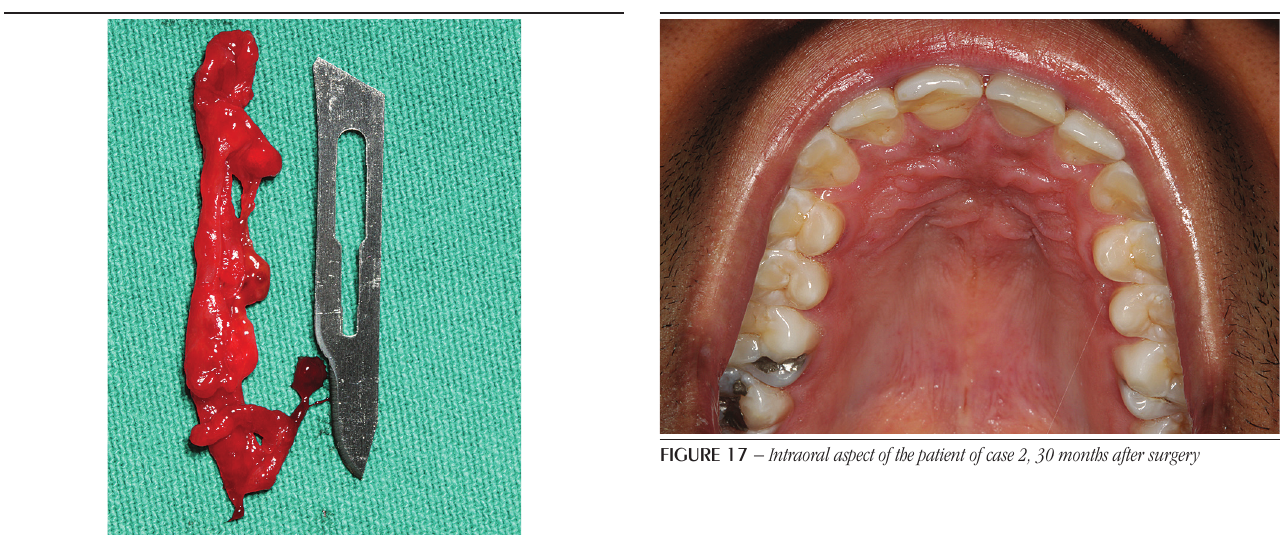
figurE 14 − Specimen